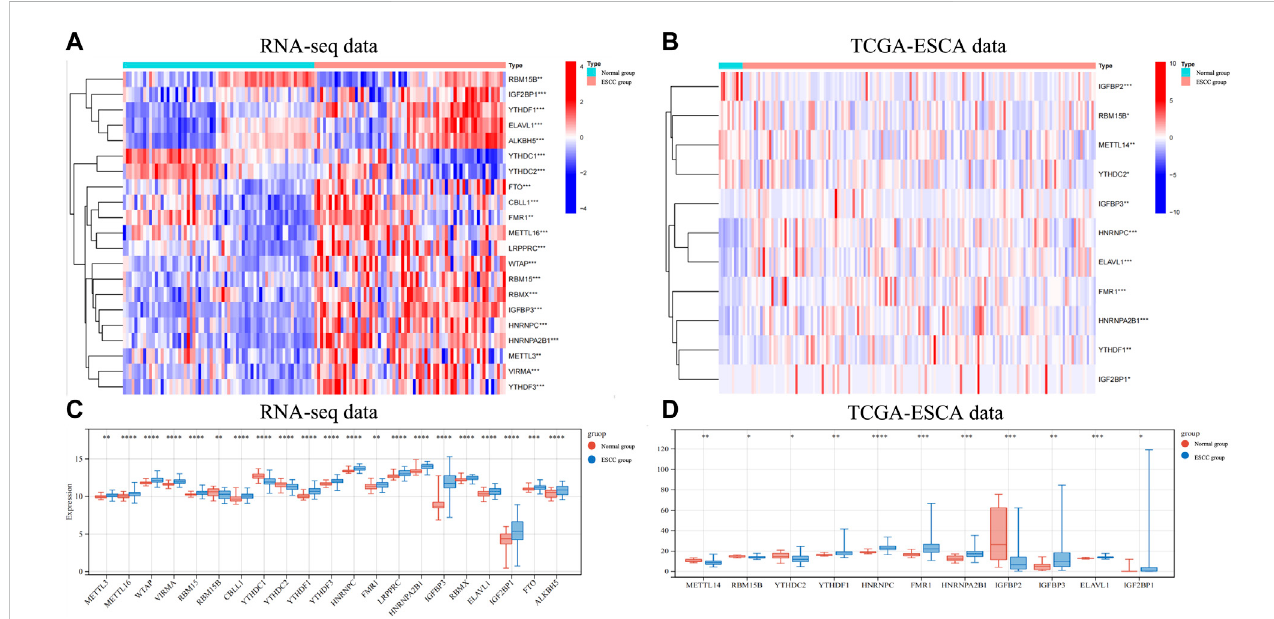
FIGURE 1 The expression of different m6A RNA methylation regulators in RNA-seq data andin TCGA-ESCA data. (A) The heatmap showed 21 signi fi cantly different expression of m6A regulators in each sample extracted from our RNA-seq data. (B) The heatmap of 11 differentially expressed m6A regulators in each sample extracted from TCGA-ESCA database. (C) The expression of 21 differentially expressed m6A regulators between normal and ESCCtissues in our RNA-seq cohort. (D) The expression of11differentiallyexpressedm6A regulators betweennormal andESCC tissues inTCGA-ESCA cohort.Dataare shownas the means ± SD. * p < 0.05, ** p < 0.01, *** p < 0.001; m6A, N6-methyladenosine; ESCA, esophageal squamous cell carcinoma; TCGA, The Cancer Genome